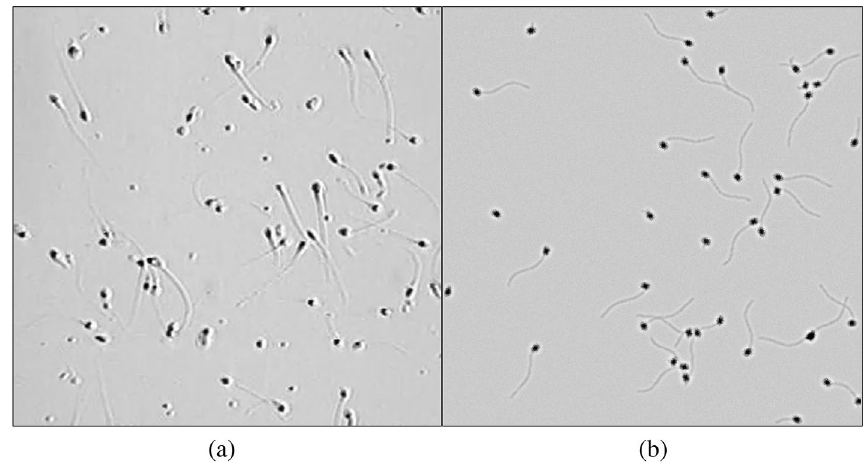
Figure 1. ( a ) Image of real human semen sample. ( b ) Image of simulated semen